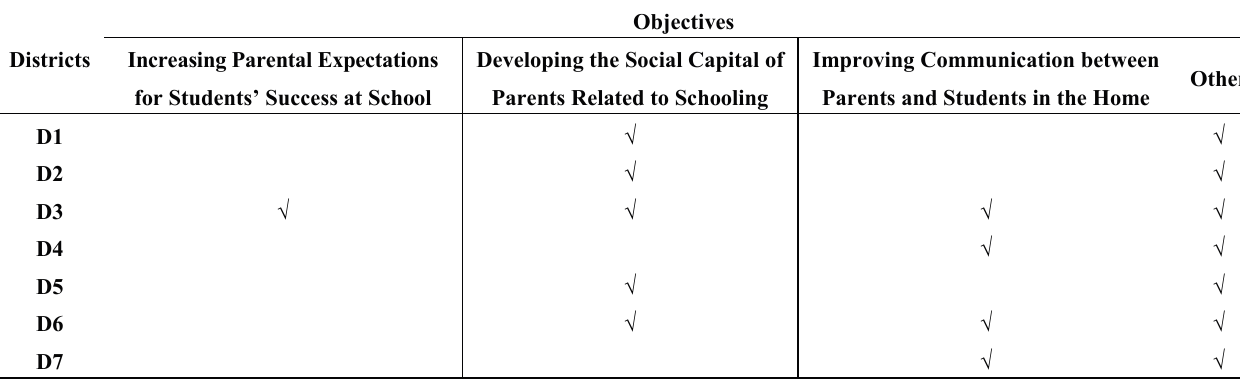
Table 1. Objectives Selected by Districts for their Parent Engagement